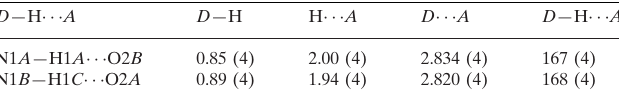
Hydrogen-bond geometry (A˚ , (cid:2) ). D —H (cid:3)(cid:3)(cid:3)